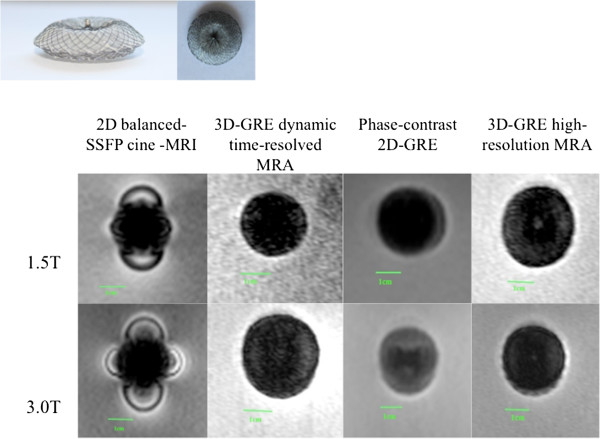
MR appearance Atrial Septal Occluder (Device 7).